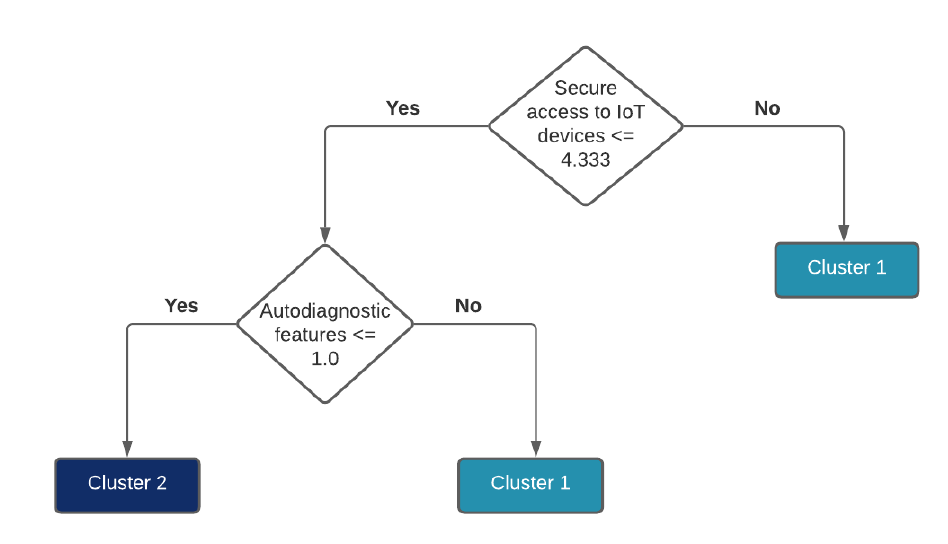
Figure 7. Taxonomy for two clusters from Figure 5 (in line with clusters from Figure